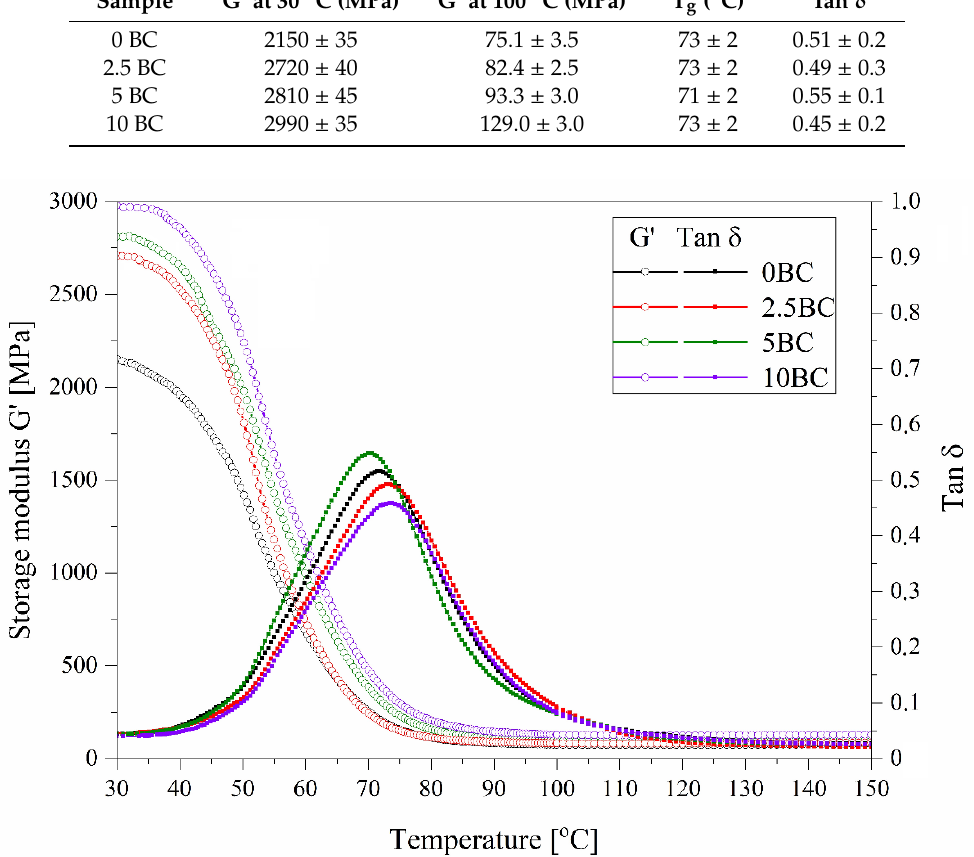
Figure 4. Graph of dependence of storage modulus (G’) and damping factor (tan δ ) values on temperature obtained by the DMTA. Table 1. DMTA analysis data: storage modulus (G’), glass transition temperature (T g ) and damping factor (Tan δ ).